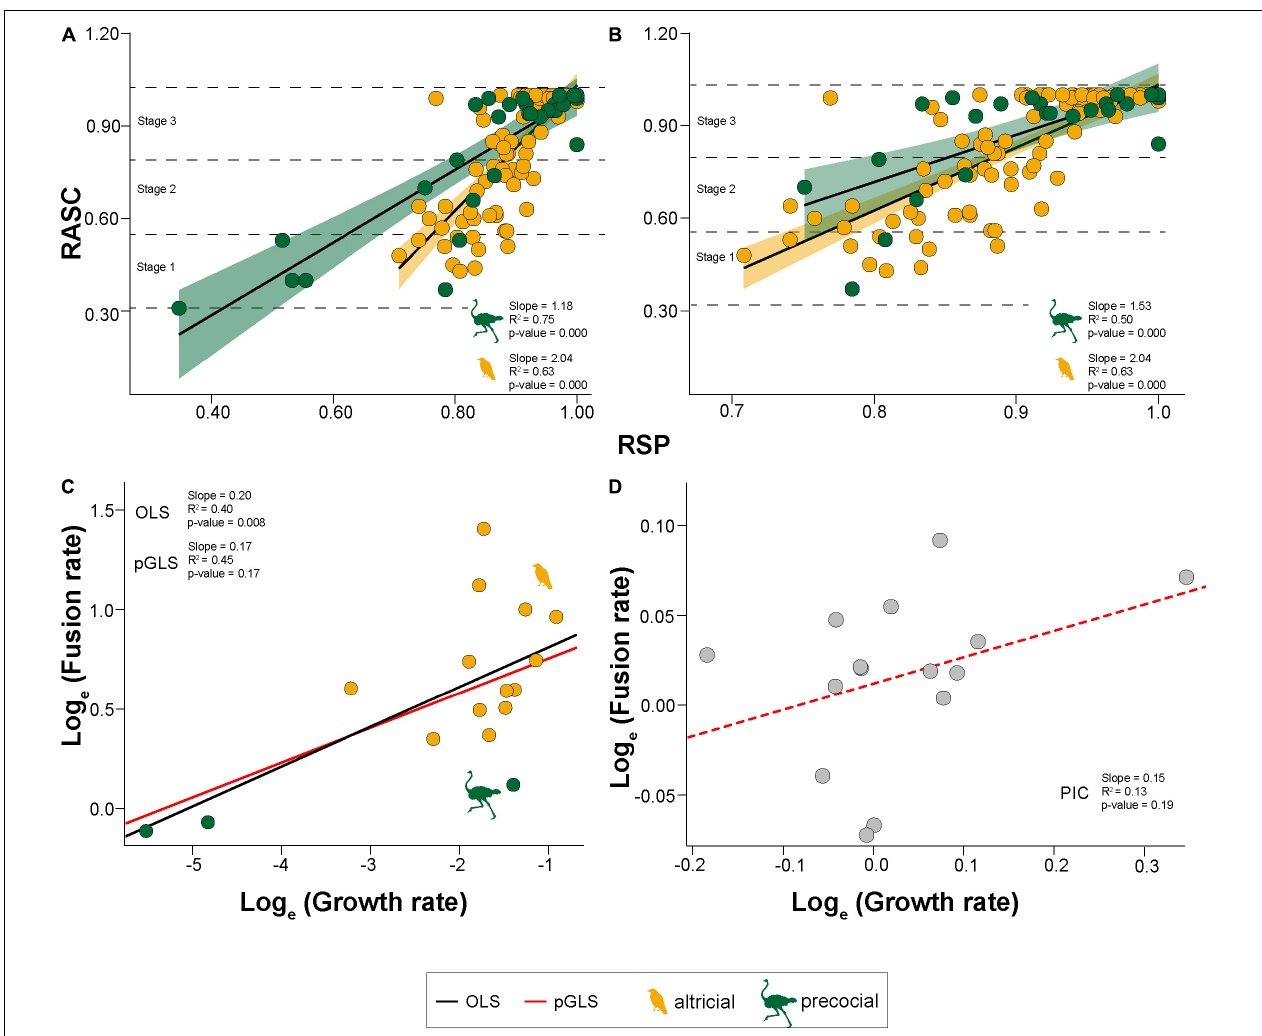
FIGURE 2 | Bivariate and phylogenetic regressions. (A) OLS regression (black line) between relative average sutural closure (RASC) and the relative size proportion (RSP) for altricial (orange) and precocial birds (green). Horizontal dashed lines represent the separation between the three stages. (B) Same results as A with standardized relative size range. (C) OLS regression (black) and phylogenetic Generalized Least Squares regression (pGLS) (red) between the fusion rate and growth rate (both log e -transformed). (D) Phylogenetically Independent Contrasts of the regression (red dashed line) between the fusion rate and growth rate (both log e